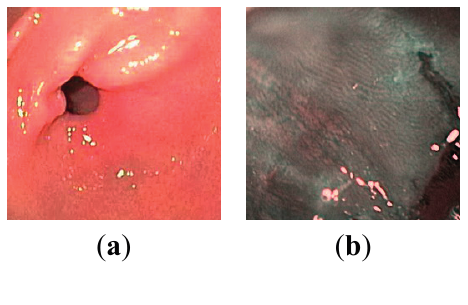
Figure 3. Sample endoscopy images: ( a ) WLI; ( b )